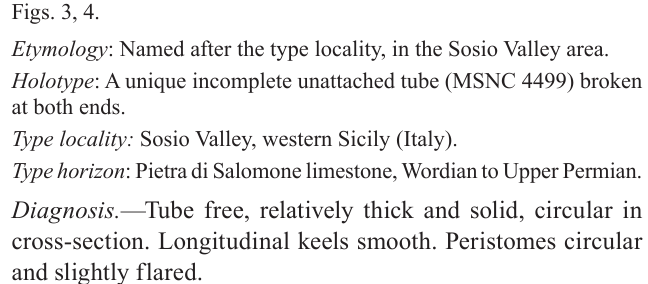
Etymology : Named after the type locality, in the Sosio Valley area. Holotype : A unique incomplete unattached tube (MSNC 4499) broken at both ends. Type locality: Sosio Valley, western Sicily (Italy).